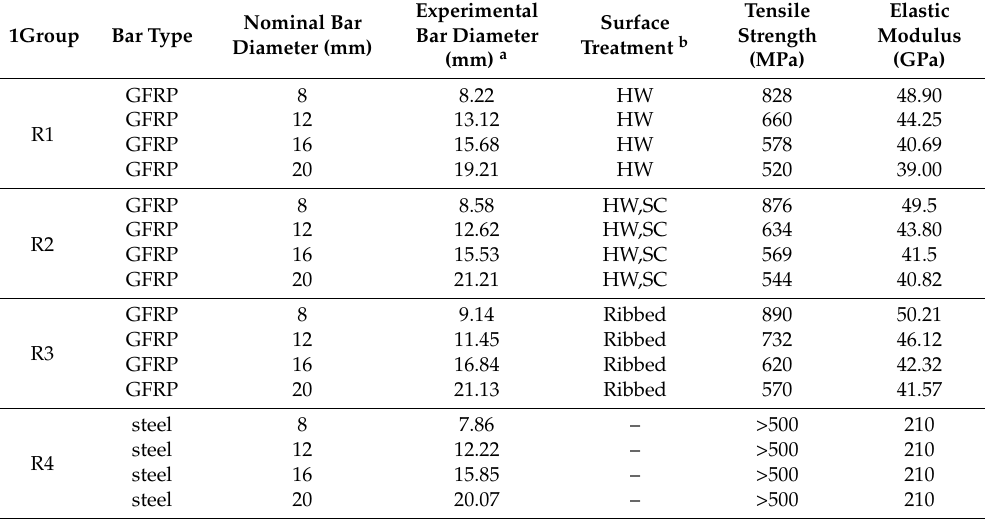
Figure 1. Surface deformations and characteristics of bars (R1–R4). Table 1. Geometrical and mechanical properties of the bars.